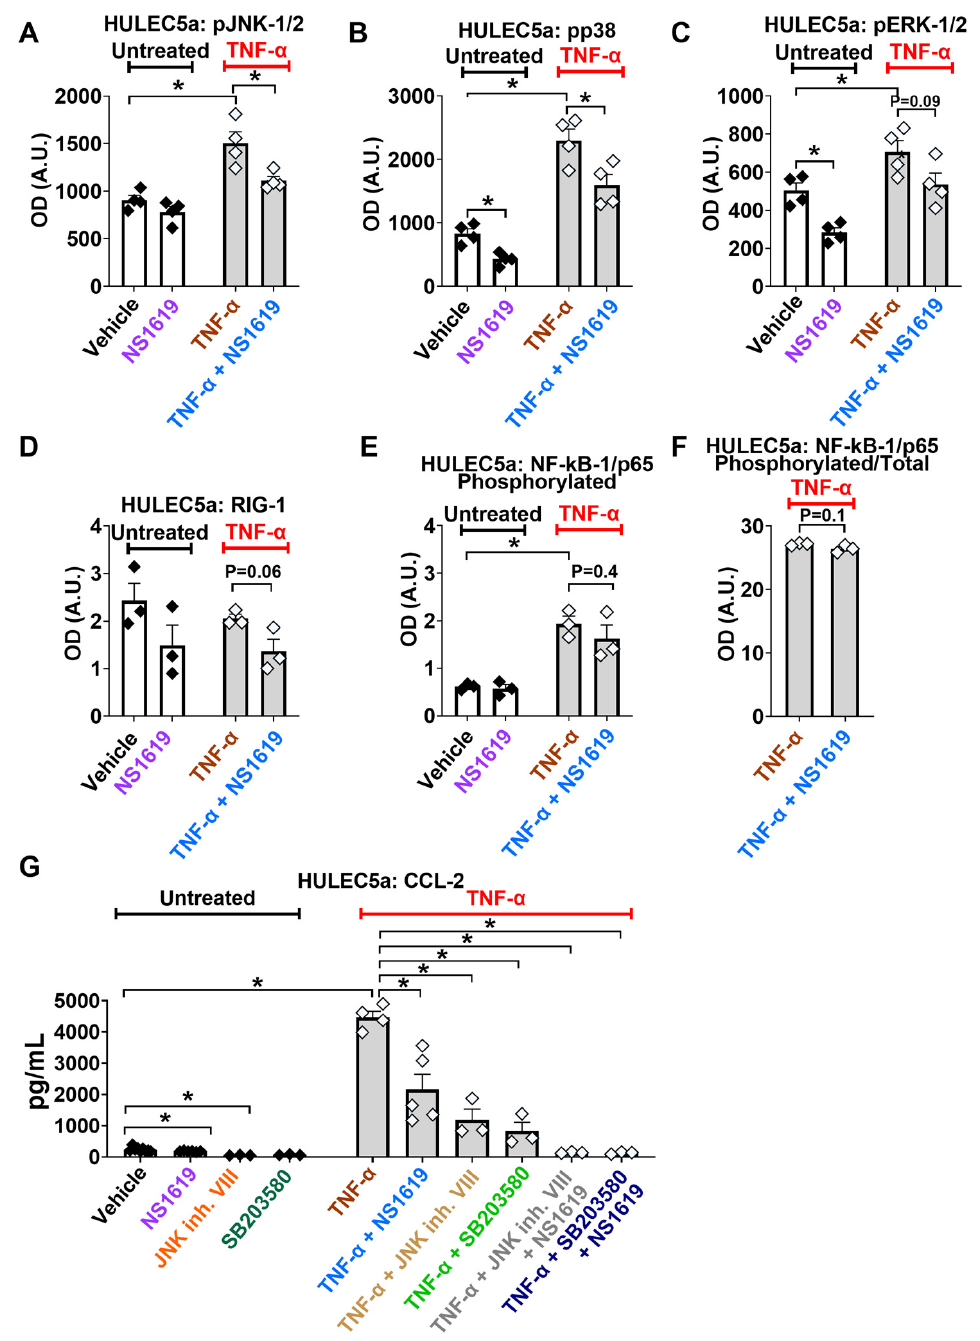
Figure 3. BK channel activation inhibits TNF- α -induced MAPK but not NF-kB-1/p65 or RIG-1 pathways. The treatment of HULEC5a endothelial cells with the BK channel opener NS1619 (30 µM, for 24 h) inhibits the TNF- α -induced (5 ng/mL; 24 h) phosphorylation of the Ca 2+ -dependent JNK-1/2 ( A ) and p38 pathways ( B ), but has no effect on RIG-1 expression or the phosphorylation of ERK-1/2 and NF-kB/p65 ( C – F ) ( n = 3–4, * p ≤ 0.05) as shown by ELISA-based multiplex assays. ( G ) The inhibition of JNK-1/2 (JNK inhibitor VIII, 20 µM, 24 h) and p38 (SB203580, 20 µM, 24 h) pathways, with or without NS1619, decreases TNF- α -induced (5 ng/mL; 24 h) CCL-2 secretion from HULEC5a cells ( n = 3–4, * p ≤ 0.0001), shown by ELISA. n = number of separate cell passages, which are considered biological replicates.